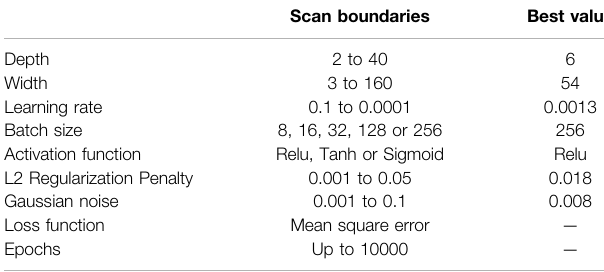
TABLE 2 | Hyperparameter boundaries for neural network hyperparameter scan and the best determined value for each case.